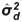
A correlation between the variance of phenotype explained by the GxE kinship matrix (σ^d2) and the inflation factor on GEI statistics (λGC) for HMDP GxE GWAS data.The correlation is plotted for the three methods; OLS (A), One RE (B), and Two RE (C). Each dot is each phenotype. The red line is a regression line between λGC and σ^d2, and Pearson correlation coefficient is indicated on the bottom right of the plot.